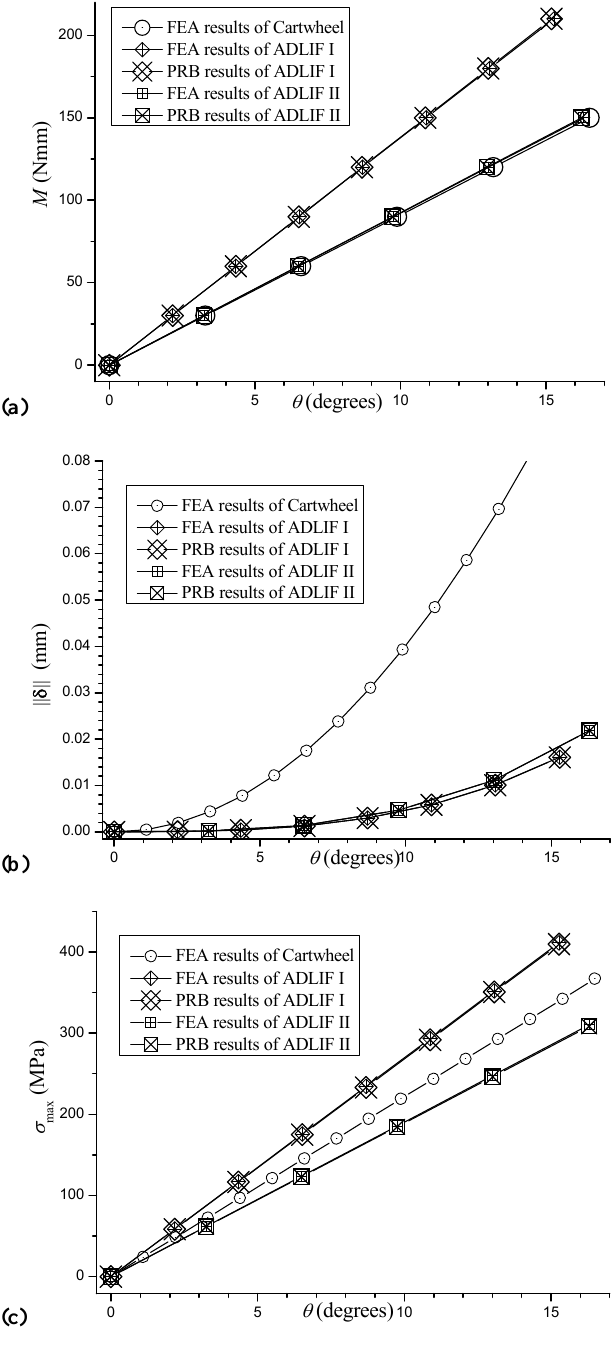
Figure 4. Performance comparisons of a cartwheel hinge and Fig. 4 Performance comparisons of a cartwheel hinge and two ADLIFs: (a) Stiffness; (b) Center-shift; (c) Stress.